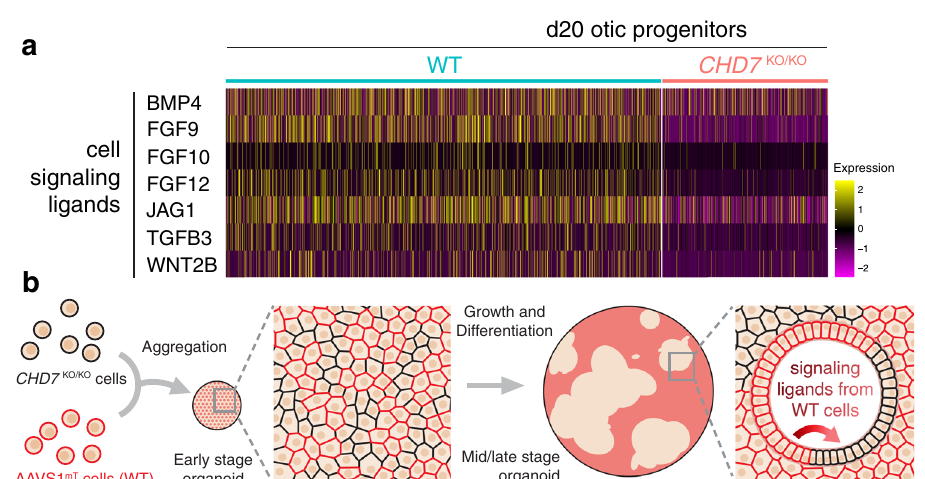
Fig. 8 | The WT- CHD7 KO/KO chimeric organoid approach is designed to test whether signaling ligands from WT cells can rescue the CHD7 KO/KO phenotypes in neighboring mutant tissues. a Heatmap showing the scaled log-normalized expression of several cells signaling ligand genes in d20 WT and CHD7 KO/KO otic